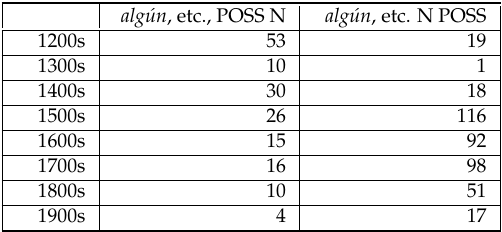
Table 12. Alg ú n , etc. + POSS + N in CdE (raw occurrences).